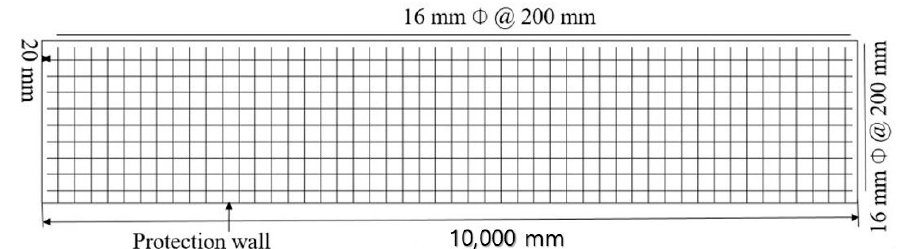
Figure 5. ( a ) LS-DYNA model for simulation; ( b ) LS-DYNA model with composite structure.